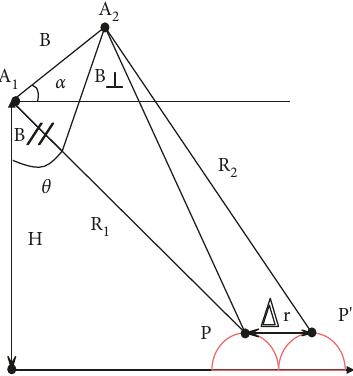
Figure 1: Basic principle of D-InSAR technology based on the two- track